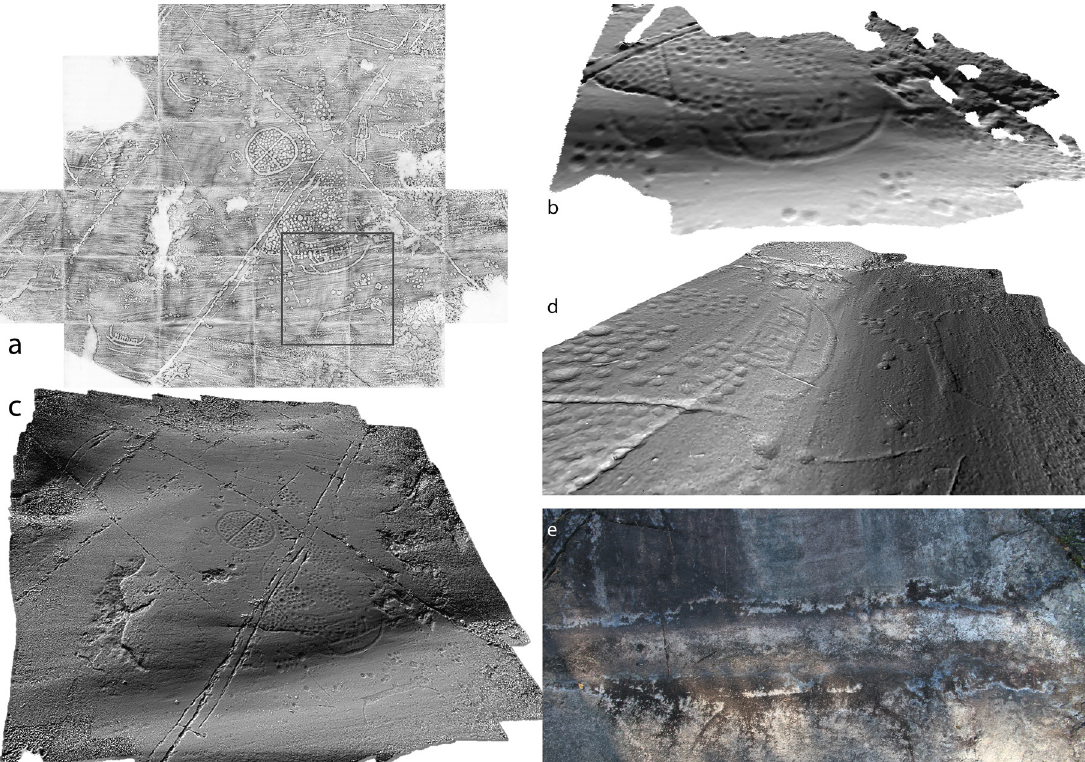
Figure 5. a. Frottage of Finntorp, RAÄ Tanum 184:1 by Tanums Hällristningsmuseum Underslös; b. Sense laser scan of the boat with the spearman by CH; c. SfM of the full site by RP; d. Section with the channel turned, applied radiance scaling filter